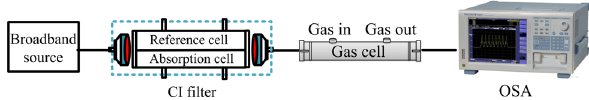
Fig. 5 Schematic of multi-gas basis verification